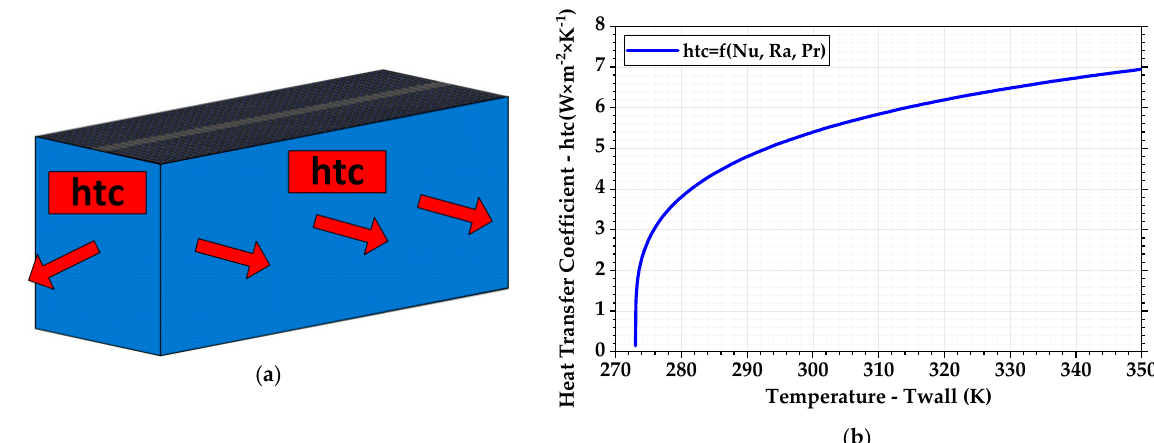
Figure 12. Applying heat transfer coefficient for external surfaces of the stack ( a ) application on external areas, ( b ) temperature dependence of heat transfer coefficient.